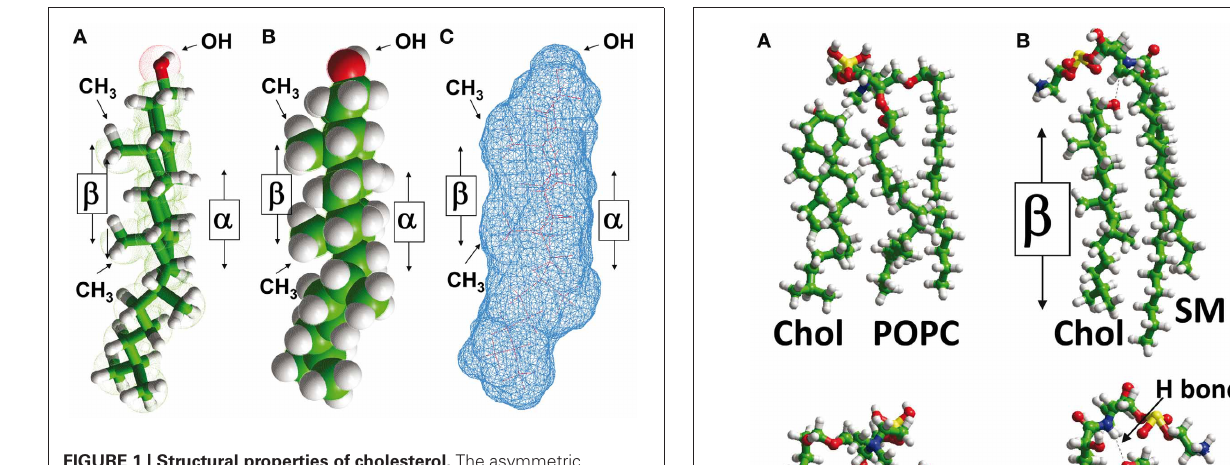
FIGURE 1 | Structural properties of cholesterol. The asymmetric distribution of aliphatic groups (methyl, iso-octyl) linked to the planar sterane backbone of cholesterol defines two distinct sides referred to as α and β faces, according to the nomenclature of ring compounds proposed by Rose et al. (1980). This asymmetric structure of cholesterol is illustrated in a tube model (A) , a sphere model (B) , and a molecular surface model (C) . Note that the OH group is closer to the “smooth” α face than to the “rough” β face.